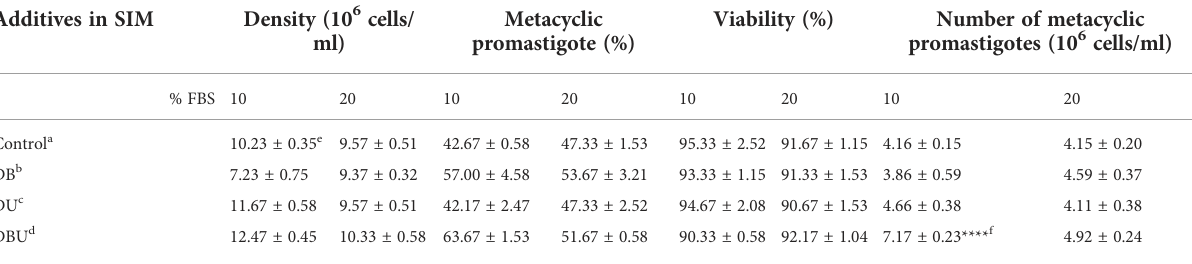
TABLE 1 Parasite density, percentage of metacyclic promastigote, percentage viability, and the number of L. orientalis metacyclic promastigotes in SIM, pH 5.0 supplemented with different additives and concentrations of FBS (10% or 20%) on day 4 of cultivation. Additives in